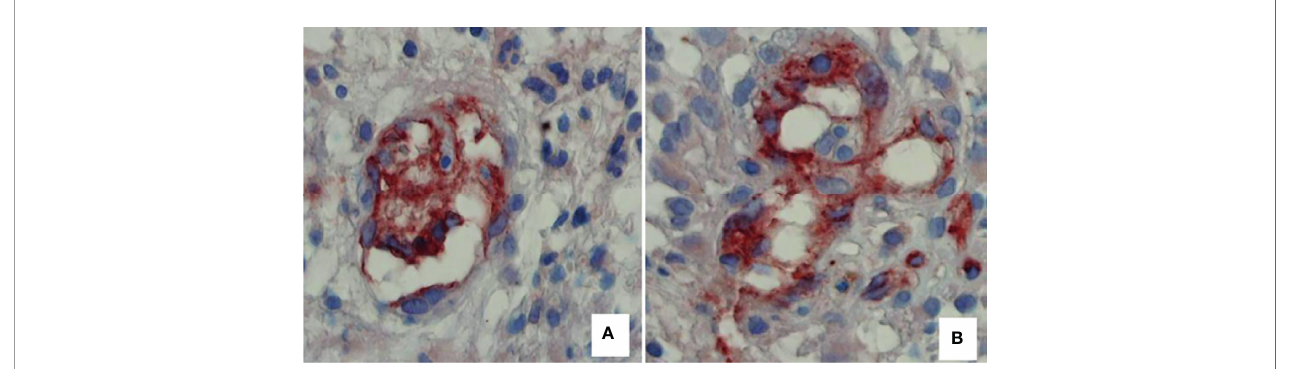
FIGURE 3 | Two examples of tumor vessels, respectively, with a low and high number of connections of intraluminal tissue folds with the opposite vascular wall, expression of intussusceptive microvascular growth in II malignancy grade tumor specimen (A) , compared with IV malignancy grade (B) . Blood vessels have been identi fi ed by immunohistochemical reaction with an anti-CD31 antibody. Original magni fi cation: x 60 (Reproduced